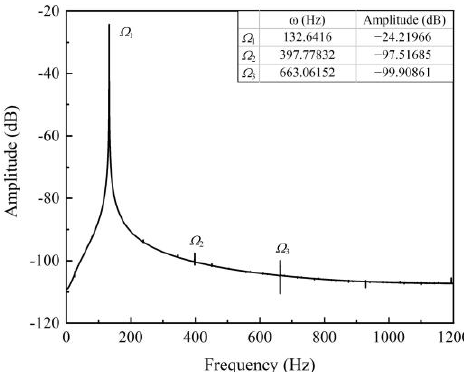
Figure 4. Response spectrogram of double-beam coupled vibration model.